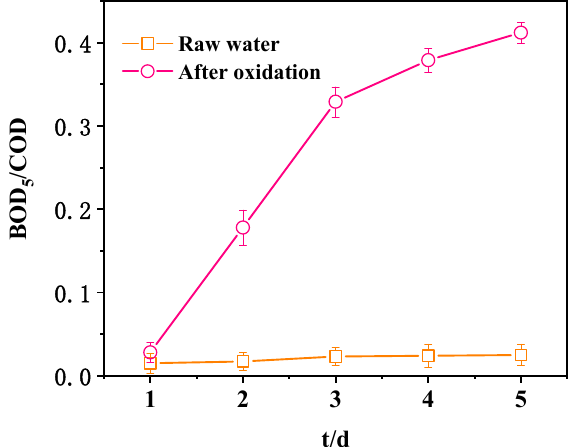
Figure 16. Comparison of BOD 5 /COD before and after oxidation.